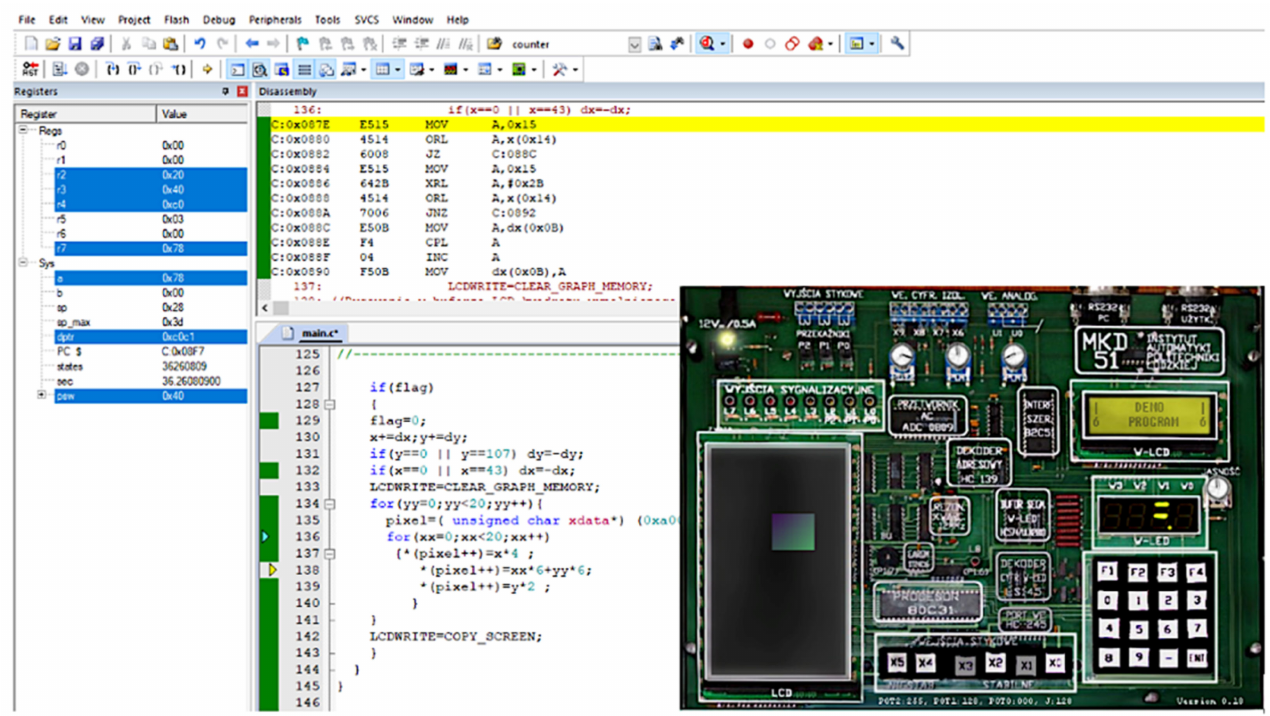
Figure 3. The MKD-51 virtual simulator runs under debugging process inside Keil µ Vision